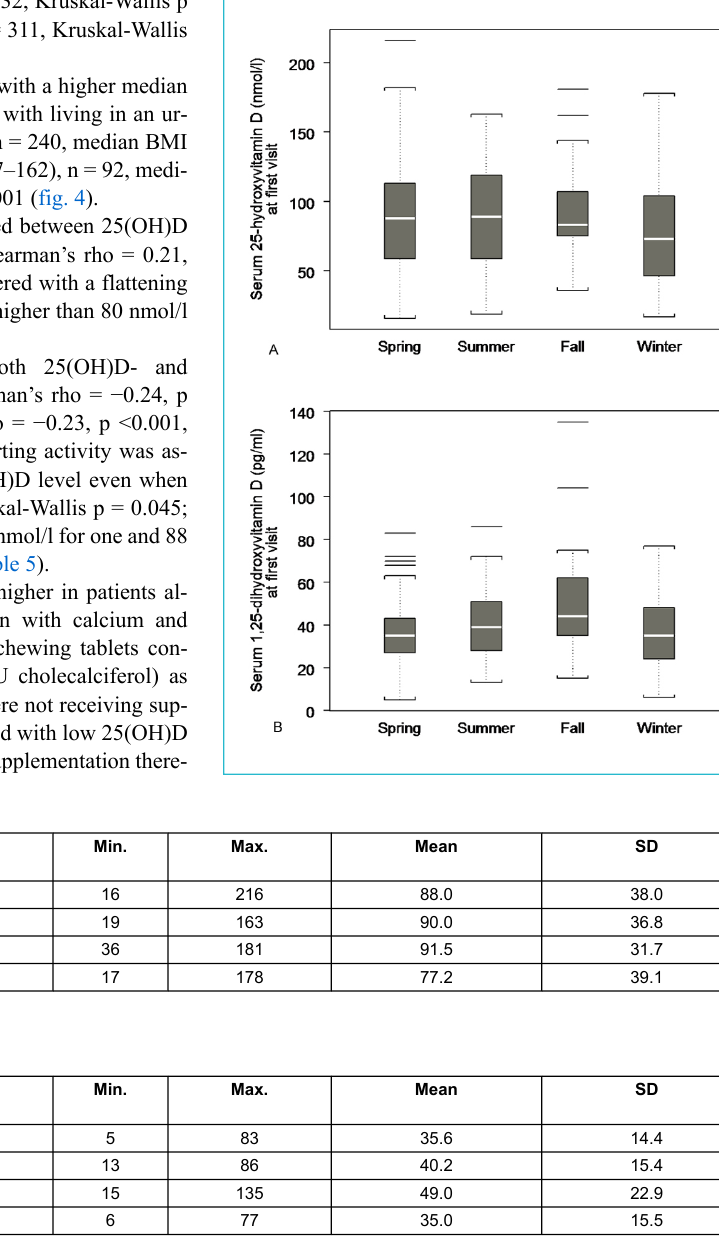
Figure 3: Seasonality of serum 25(OH)D (a) and 1,25(OH)2D (b) levels. Note that seasonality was more pronounced for 1,25(OH)2D, hinting at insufficient 25(OH)D levels in a large pro- portion of patients: sharp decreases in 1,25(OH)2D levels may im- ply 25(OH)D deficiency.